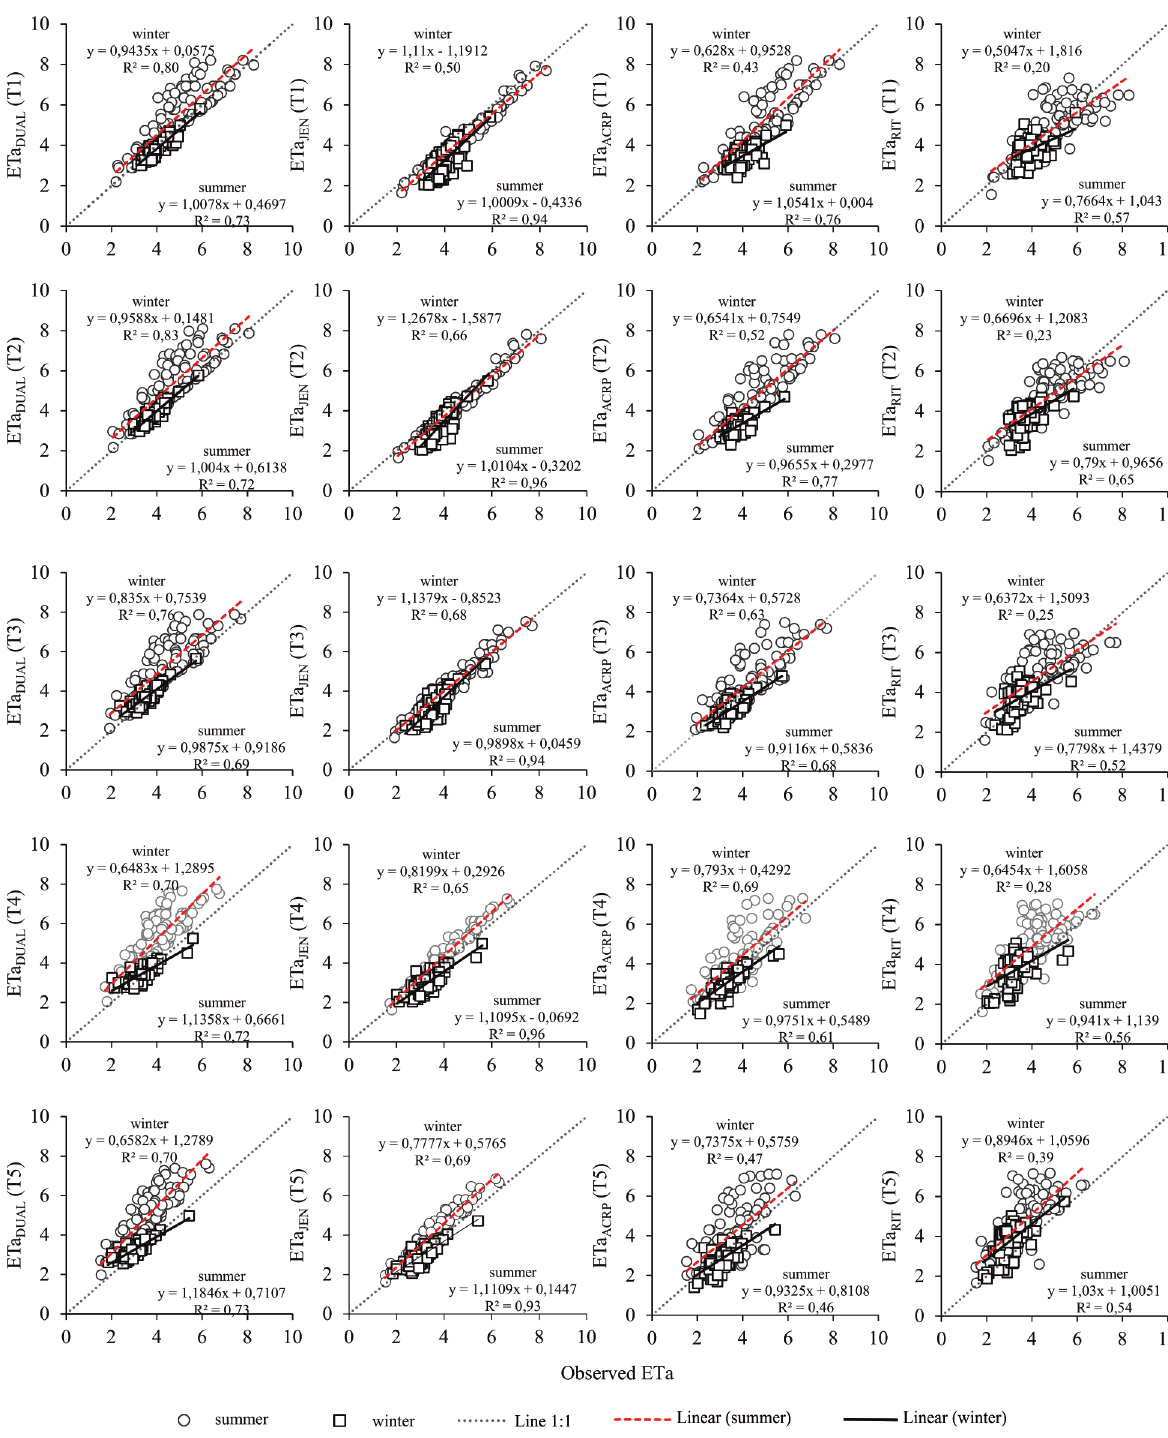
Figure 3. Comparison between values of actual evapotranspiration of soybean crop observed (ETa estimated by the models FAO56 Dual (ETa for the treatments [T1: water available in the soil (AW) of the 80-100%; T2: 60-80% AW; T3: 40-60% AW; T4: 20-40% AW and T5: 0-20% AW)] in winter and summer